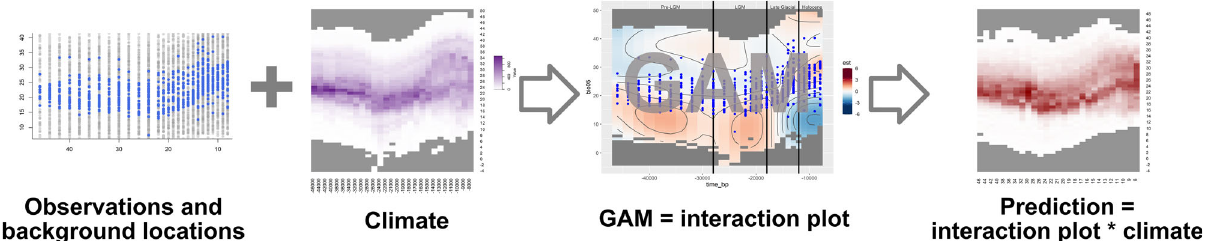
Fig. 5 Schematic description of how the GAM capture the change through time in the effect of an environmental variable. The example is based on the results for minimum temperature in